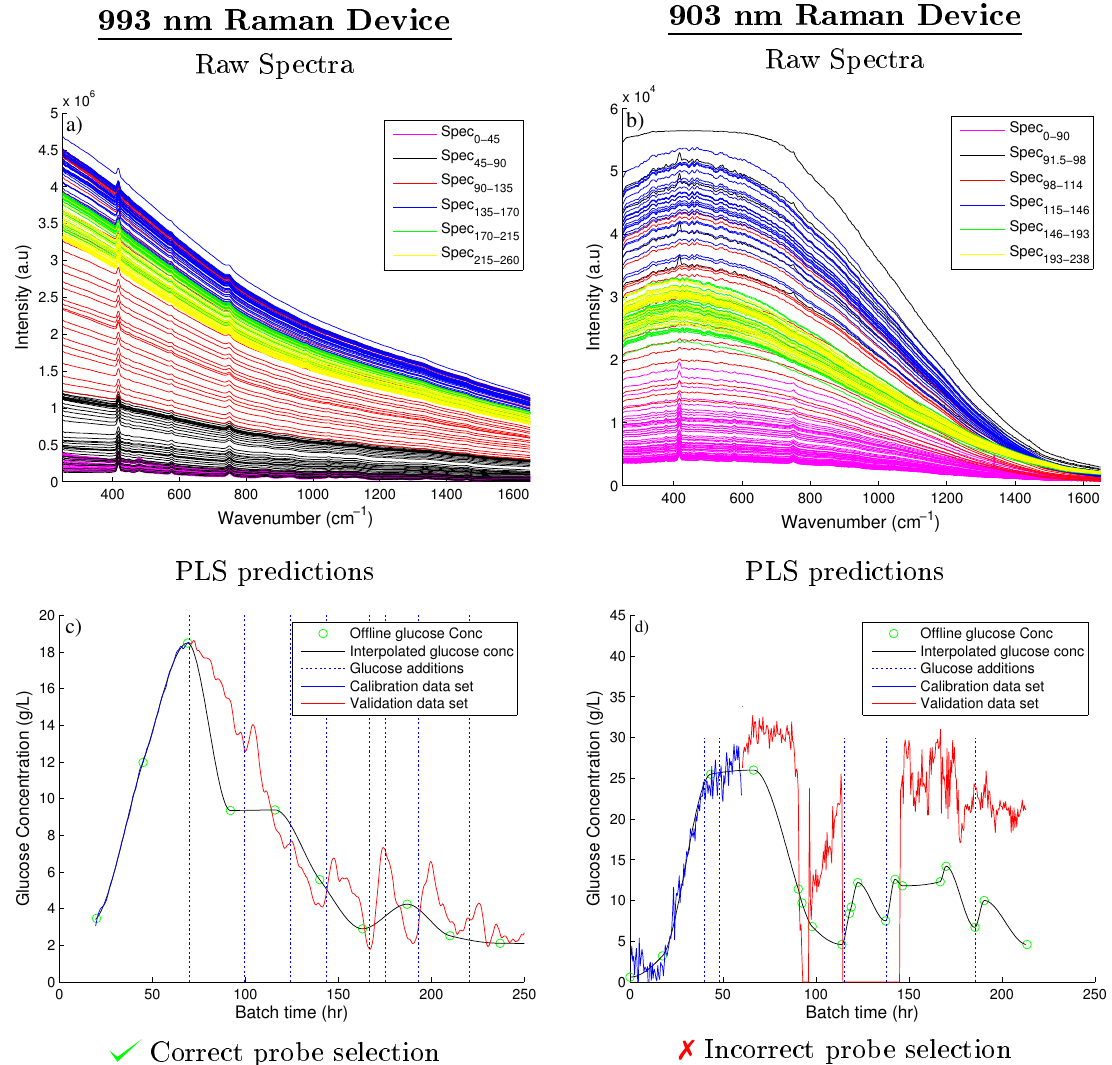
Figure 3. Raw spectra collected from the 993 and 903 nm Raman spectroscopic devices, shown in ( a , b ) respectively. The corresponding PLS model predictions compared against the on-line glucose concentrations are shown in ( c , d ),